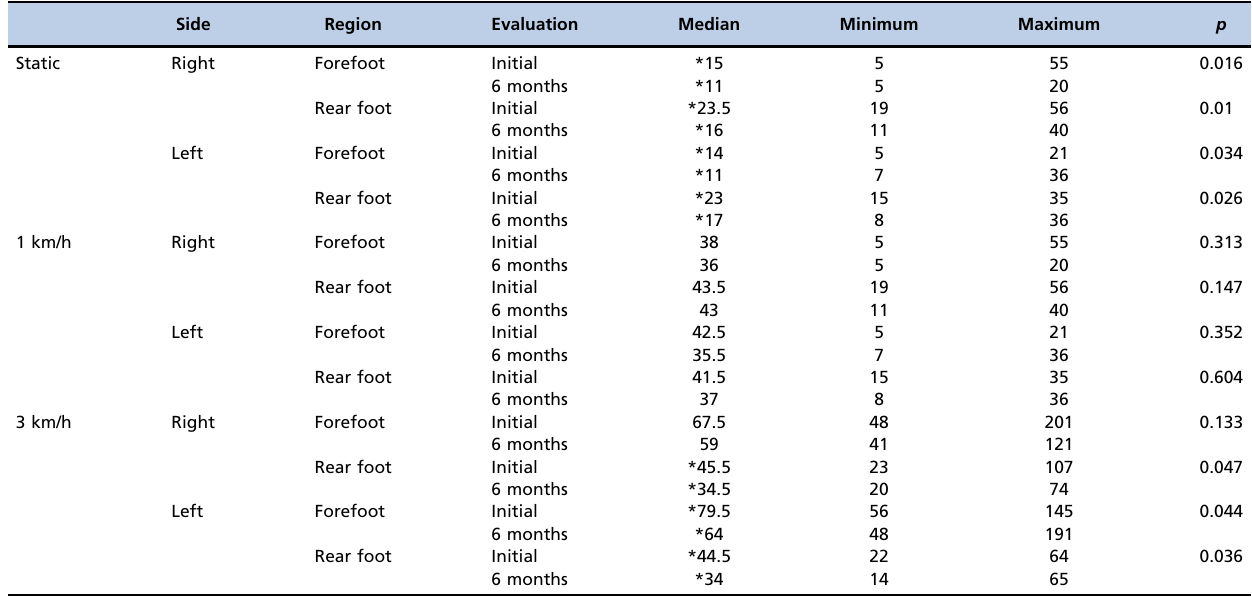
Table 4 - Descriptive statistics for the peak pressure under static and dynamic conditions (1 and 3 km/h) measured at the initial (initial) and final (six months after bariatric surgery) evaluations for the right and left feet, for the forefeet and rear feet of 16